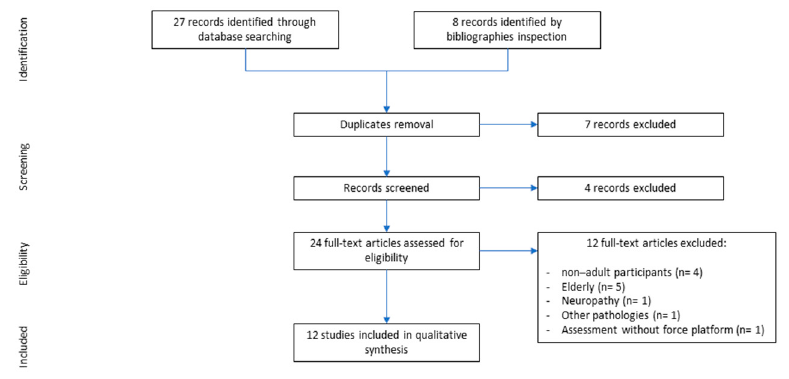
Figure 1. Diagram of study